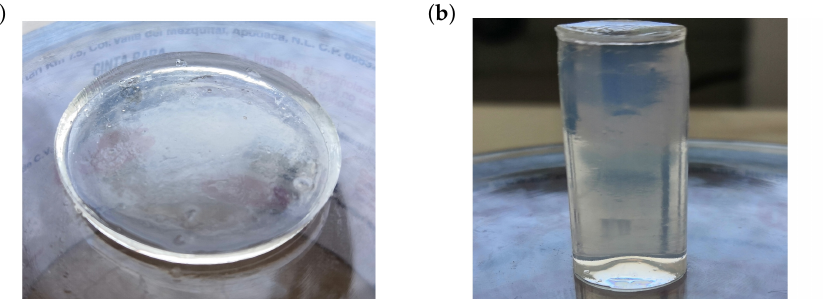
Figure 5. ( a ) Samples of PEGDA used in the swelling tests. ( b ) Samples of PEGDA used in the compression